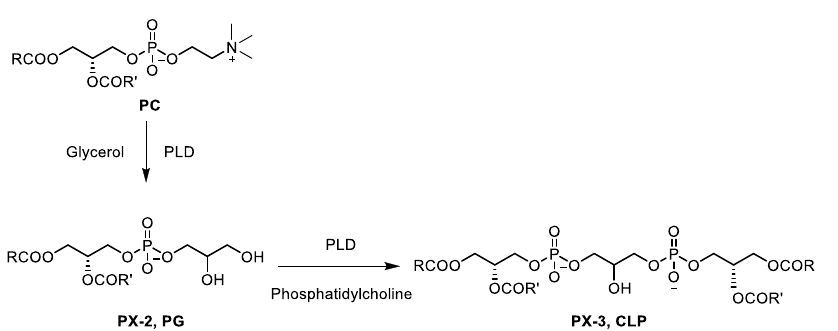
Scheme 3. Schematic equation of the synthesis of phosphatidylglycerol ( PX-2 ) and cardiolipin ( PX-3